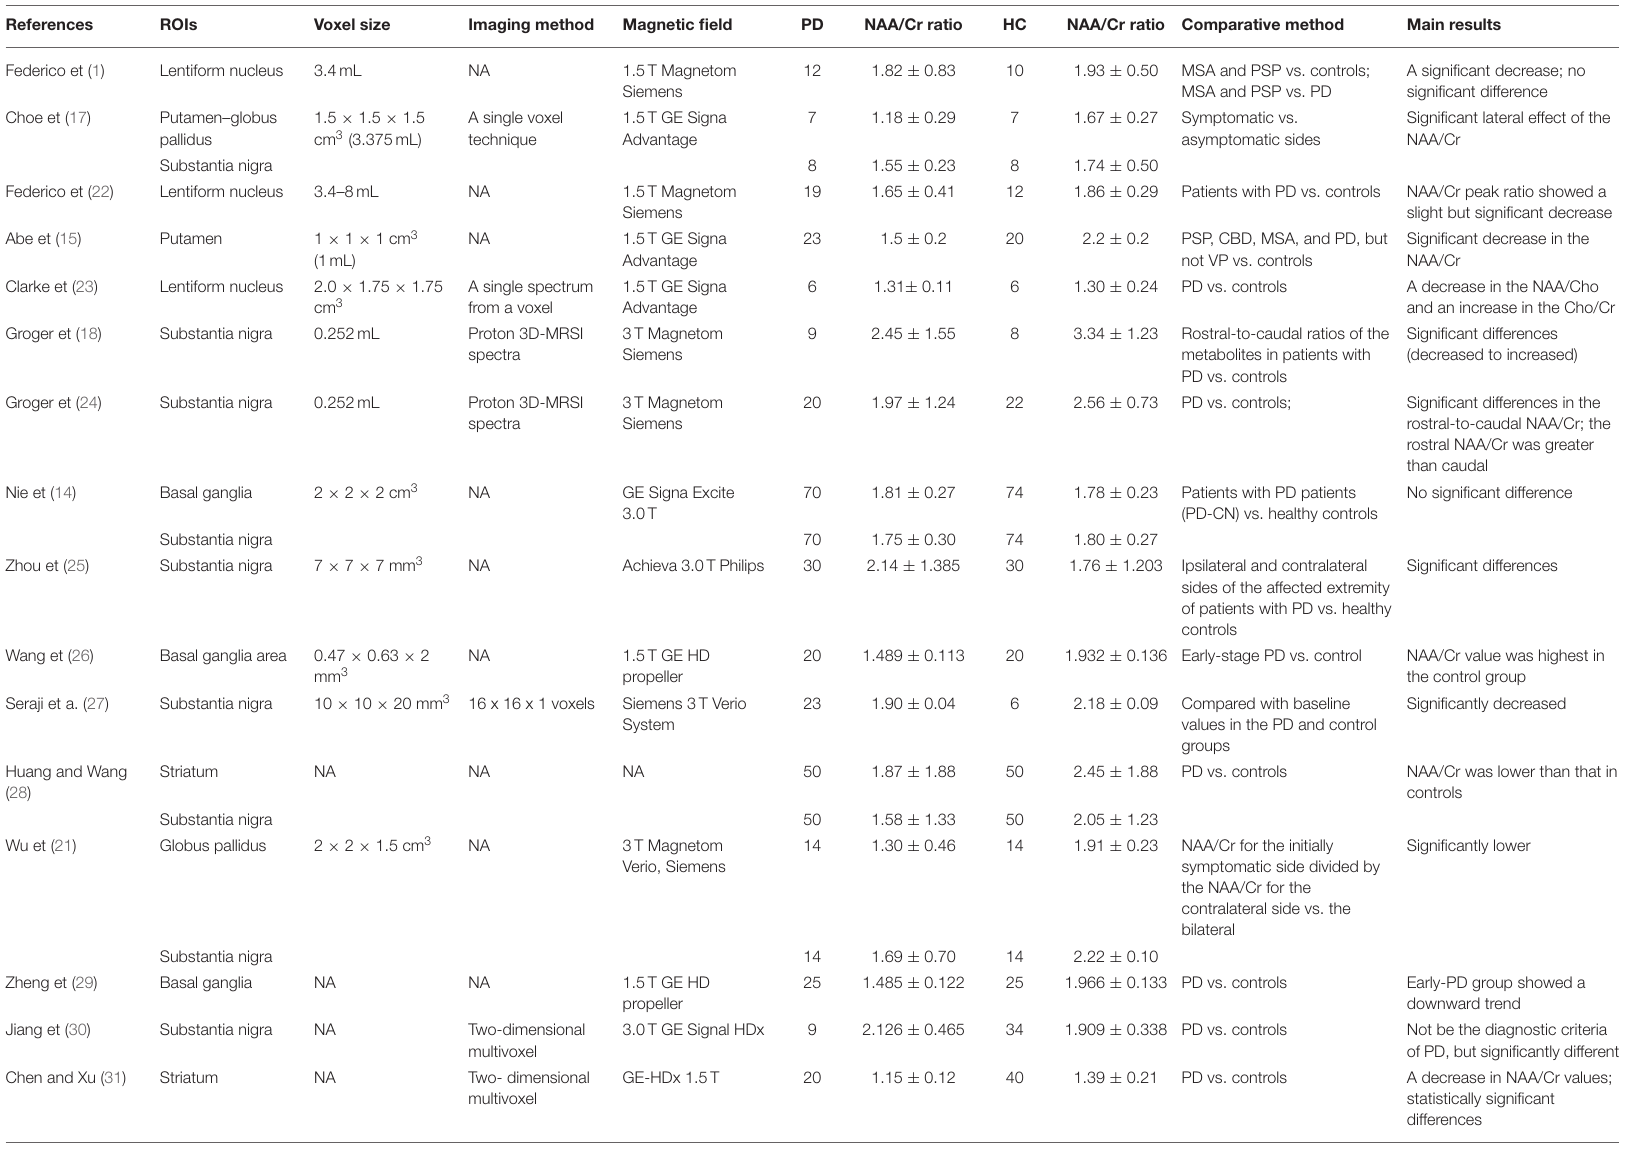
TABLE 1 | Characteristics of included studies.